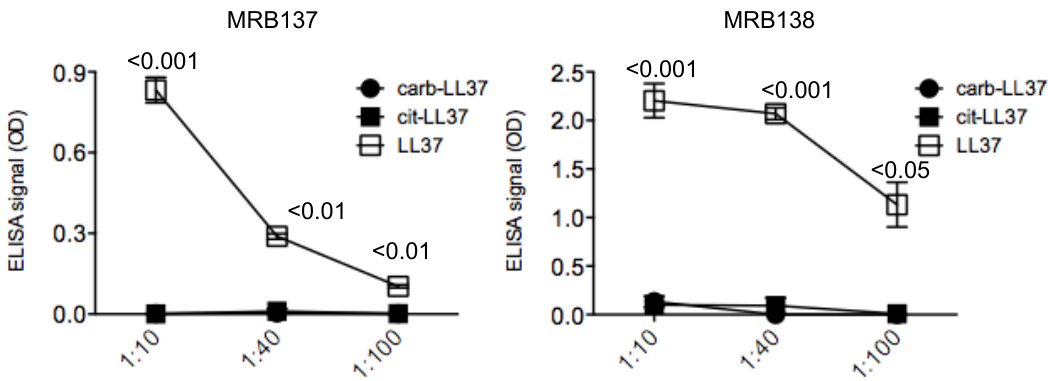
Figure 2. MRB137 and MRB138, specific for native LL37, do not cross-recognize carb-LL37.